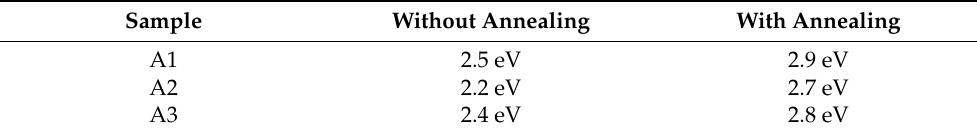
Figure 5. Square root of ( α hv ) 1/2 vs. photon energy for SRO films. The obtained band gap energies are shown in Table 3. Table 3. Energy values of the band gap of SRO films without and with annealing.